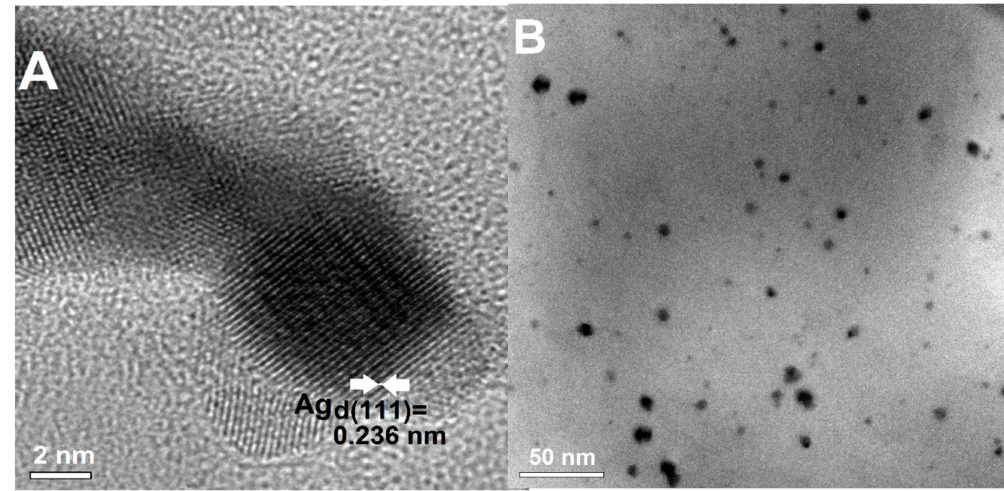
Figure 8. TEM images of the silver nanoparticles extracted from composites. ( A ) The HRTEM image of selected AgNP with visible lattice planes (111) and the interplanar spacing (d111 = 0.236 nm), ( B ) Extracted AgNP in ethanol.